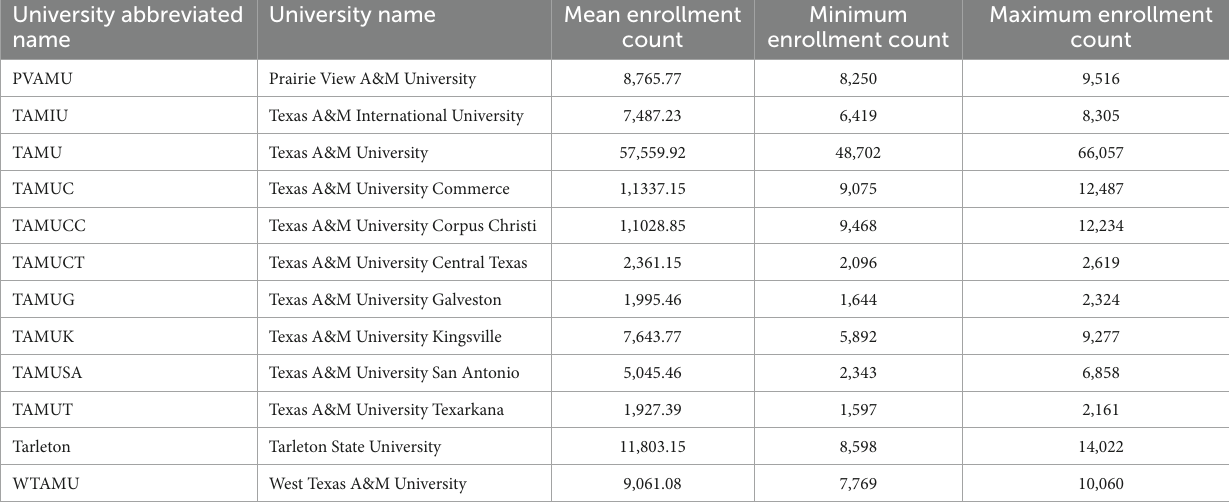
TABLE 1 Information on enrollment counts for the 12 universities sampled for this study.